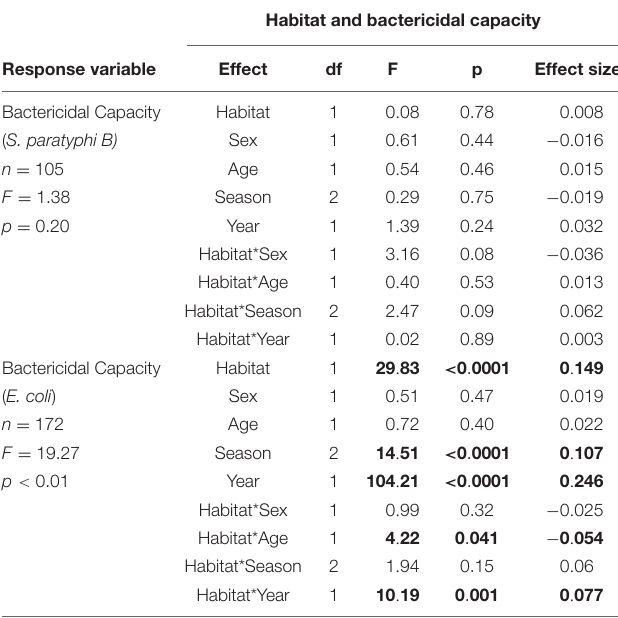
Bold values indicate statistically significant factors according to an alpha value of